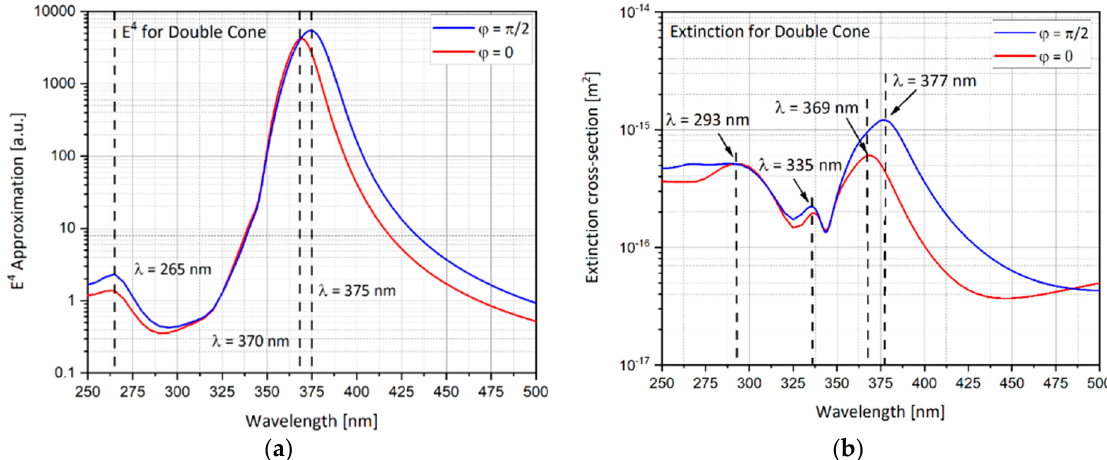
Figure 11. Double nano-cone results while changing the polar angle θ in a wavelengths range of λ = 250–500 nm. ( a ) E 4 approximation; ( b ) extinction cross-section.